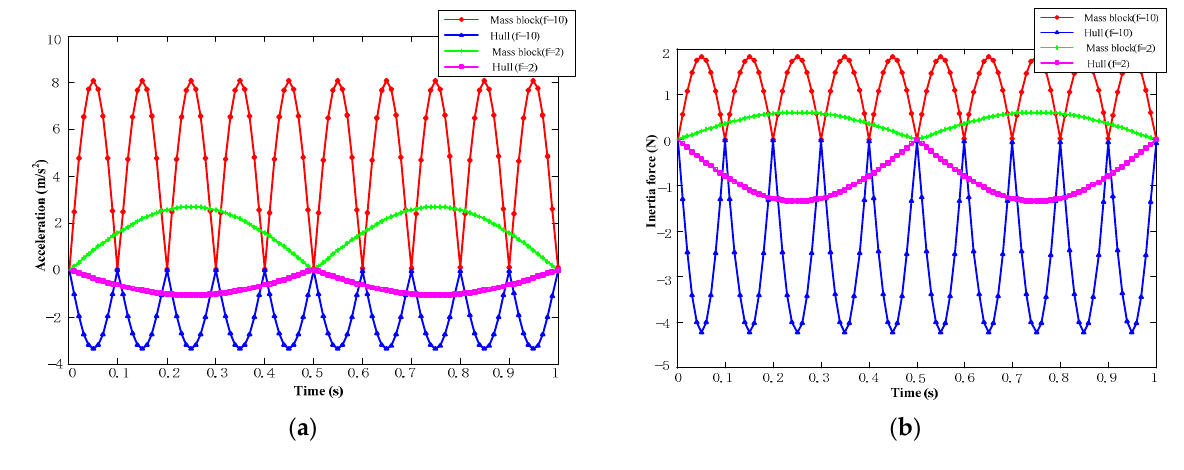
Figure 3. Acceleration and inertia force simulation diagram of mass block and base. ( a ) Acceleration diagram; ( b ) inertia force diagram.